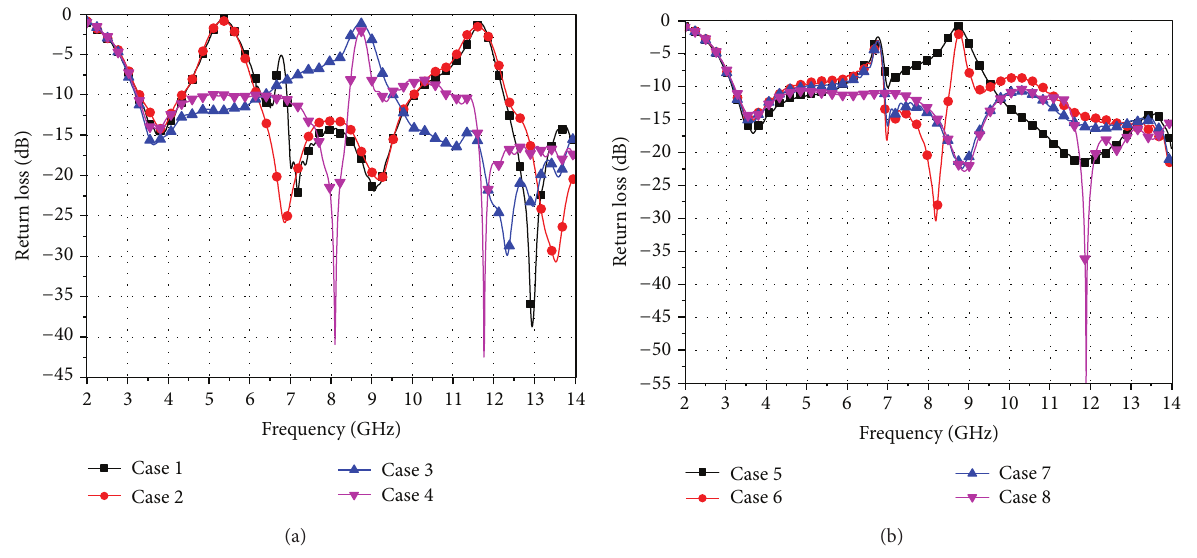
Figure 13: Switchable characteristics of CRA C with various